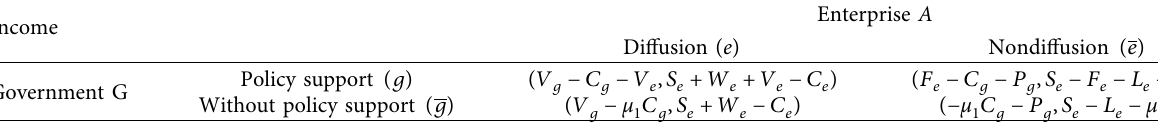
Table 1: Game payment matrix between government and